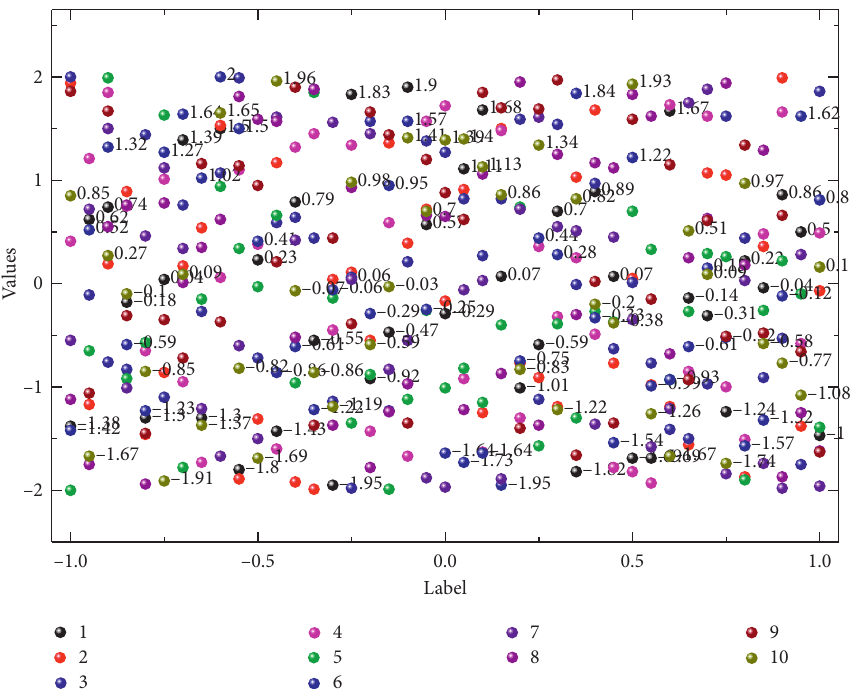
Figure 6: Calibration error analysis